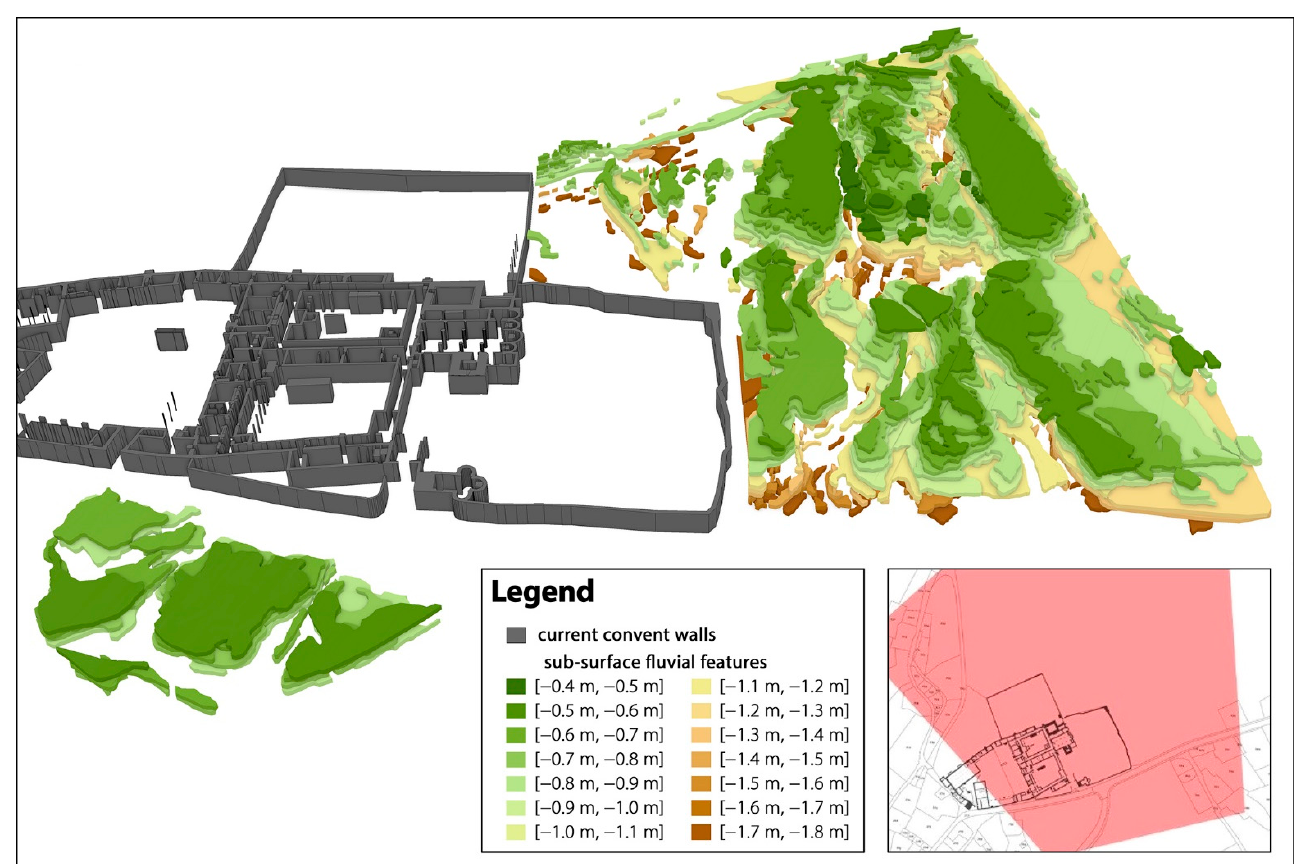
Figure 6. The intricate network of deposits related to the Valgarola alluvial